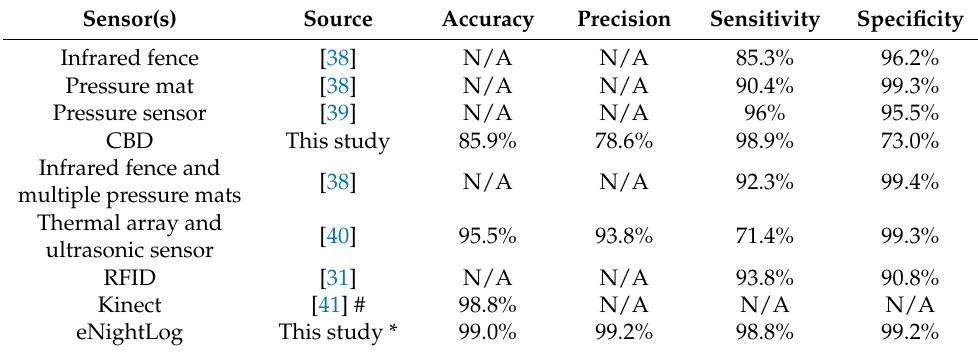
Table 6. Comparison with different studies for posture and bedside event recognition. Sensor(s)